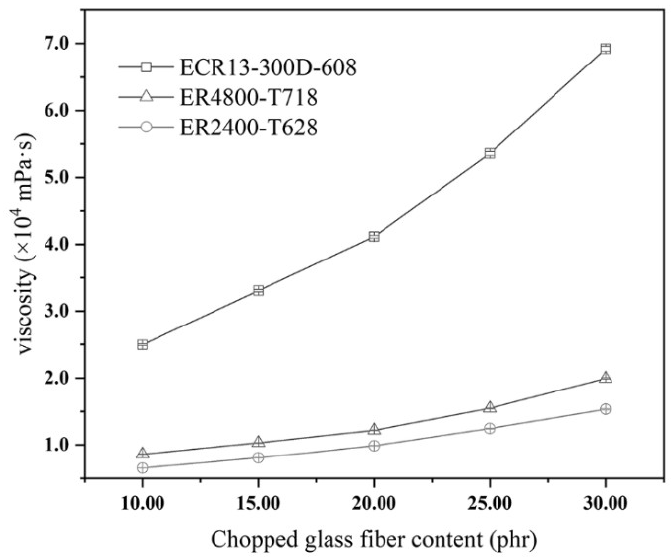
Figure 3. Effects of three types of chopped glass fiber at a length of 15.0 mm and in different contents (10.00 phr, 15.00 phr, 20.00 phr, 25.00 phr, and 30.00 phr) on the viscosity of the resin glue.